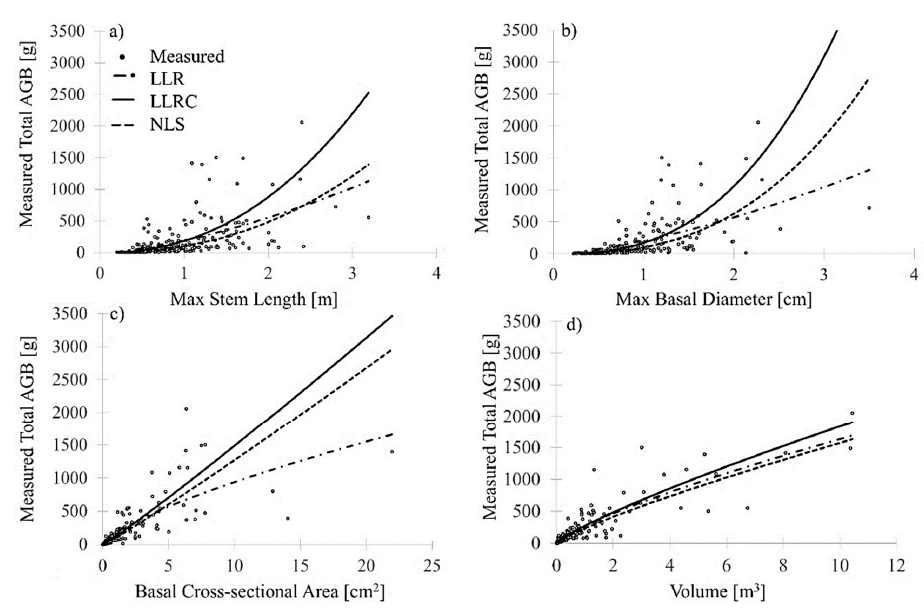
Figure 3. LLRC, LLR, and NLS model fits for each 1D ( a , b ), 2D ( c ), and 3D ( d ) predictor variable utilized to model total AGB for multispecies utilized to model total AGB for multispecies shrubs.